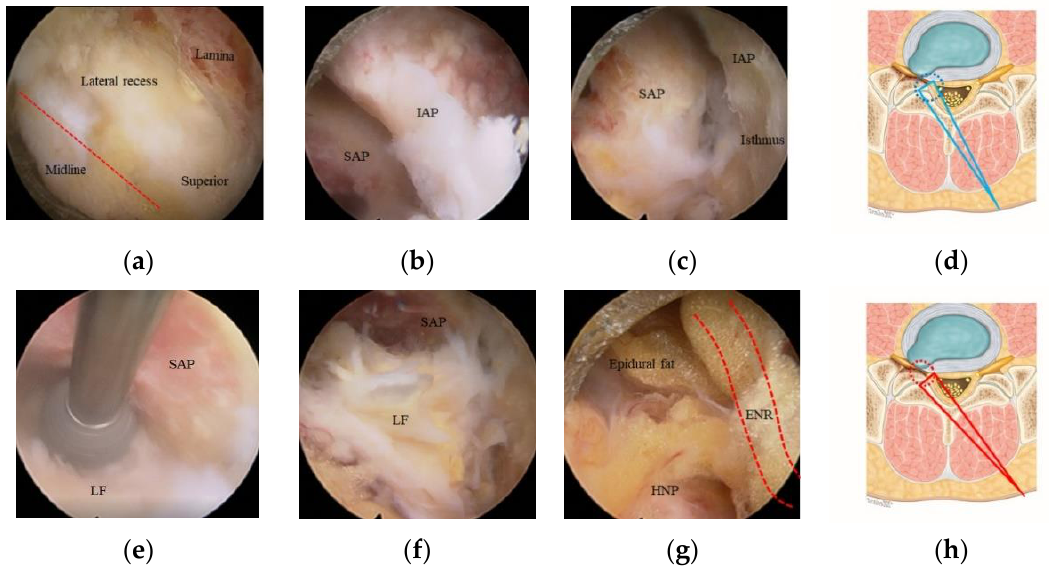
Figure 2. Intraoperative images of right-side uniportal endoscopic approach for left-side contralateral multifocal stenosis decompression at the L5-S1 level. ( a ) Contralateral sublaminar drilling was done to expose the lateral recess and foraminal entrance and then remove the hypertrophied ligamentum flavum (LF) using an endoscope with a 10-mm diameter. After lateral recess decompression, the endoscope was changed to one with a 7-mm diameter. ( b ) The medial part of the facet joint was exposed after LF removal. ( c ) After drilling the inferior articular process (IAP), the superior-medial part of the superior articular process (SAP) and attached foraminal LF were found. ( d ) The foramen exposure step (upper panel) was performed with an initially steeper trajectory (long blue triangle). The work area is outlined with a blue dotted circle. ( e ) The SAP was removed with an endoscopic drill in a tunnel shape to preserve the joint capsule, leaving the foraminal LF for nerve root protection. ( f , g ) The exposed foraminal LF was removed, the epidural fat tissue and foraminal herniated nucleus pulposus (HNP) were then found in the foraminal space. ( h ) The foramen opening step (lower panel) was done with a lower trajectory angle after endoscope levering (long red triangle). The work area is marked with a red dotted circle. ENR: exiting nerve root.